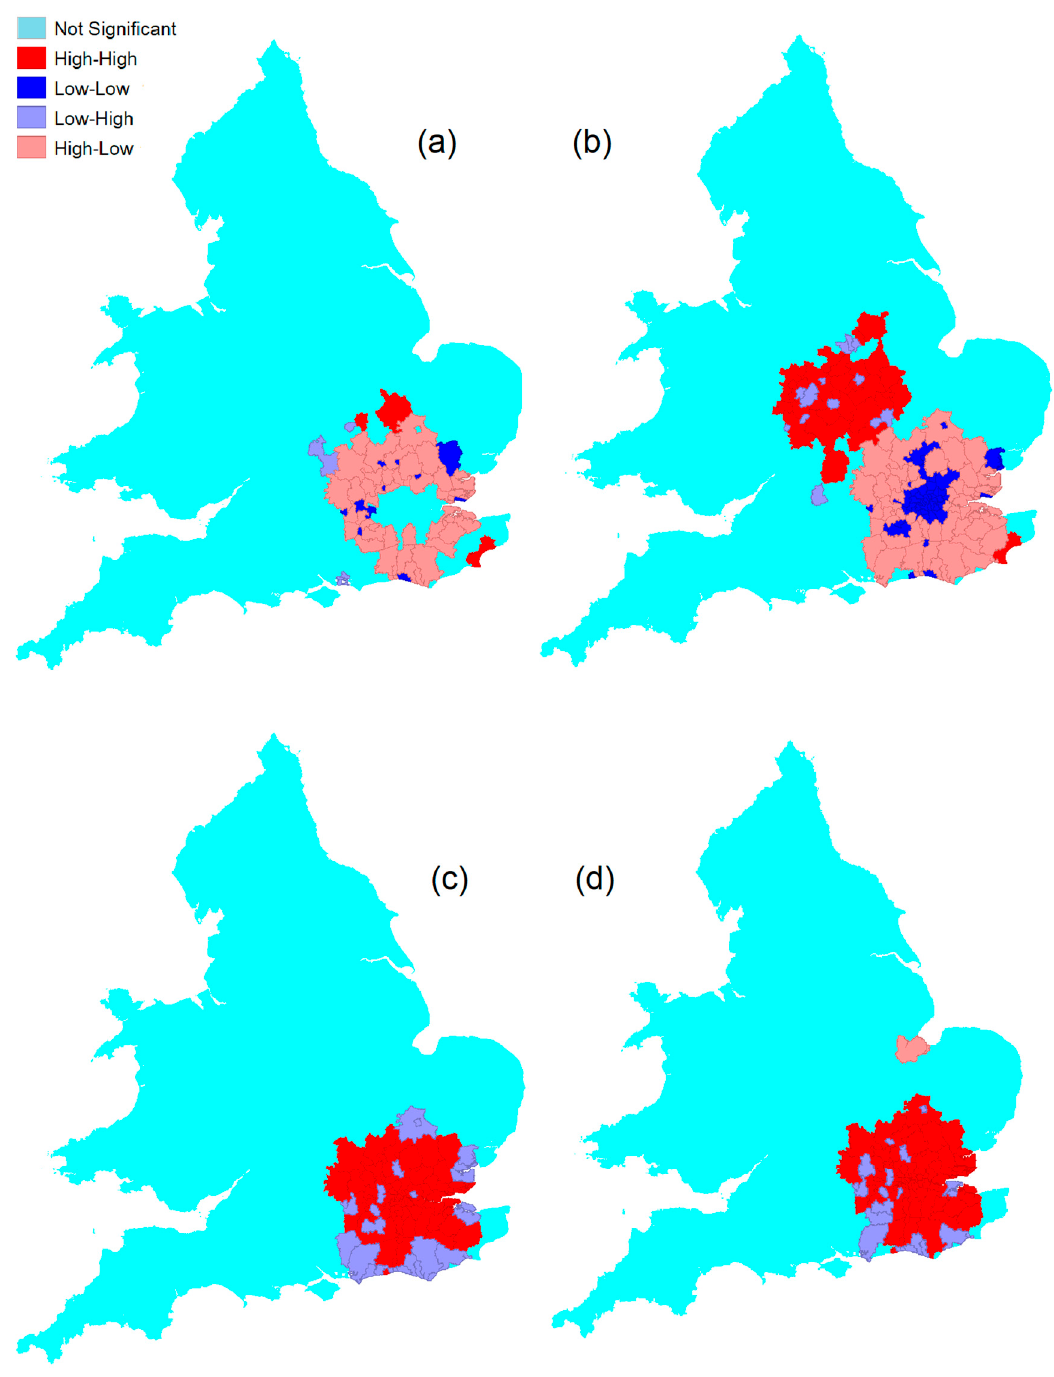
Figure 3. LISA Maps Migration (0–4 and 20–24 years old). ( a ) Range of 0–4-year-olds in 2012; ( b ) 0–4 year olds in 2018; ( c ) 20–24 year olds in 2012; ( d ) 20–24 year olds in 2018. Figure 4 covers three more age-bands (25 to 39) posited to be associated with union, dwelling purchase and first child. For 2012 (Figure 4a–c), there appears to be transition from net inward- to outward-migration. The pattern with 25–29-year-olds (Figure 4a) points to young adults moving into the Greater South East area from outside London in search of employment. The extent of the coloured area relates those of 20–24- and 0–4-year-olds. The extent of the zone in Figure 4c, associated with 35–39-year-olds, resembles that of Figure 4a. Dennett and Stillwell (2010) make the point that the migration patterns of